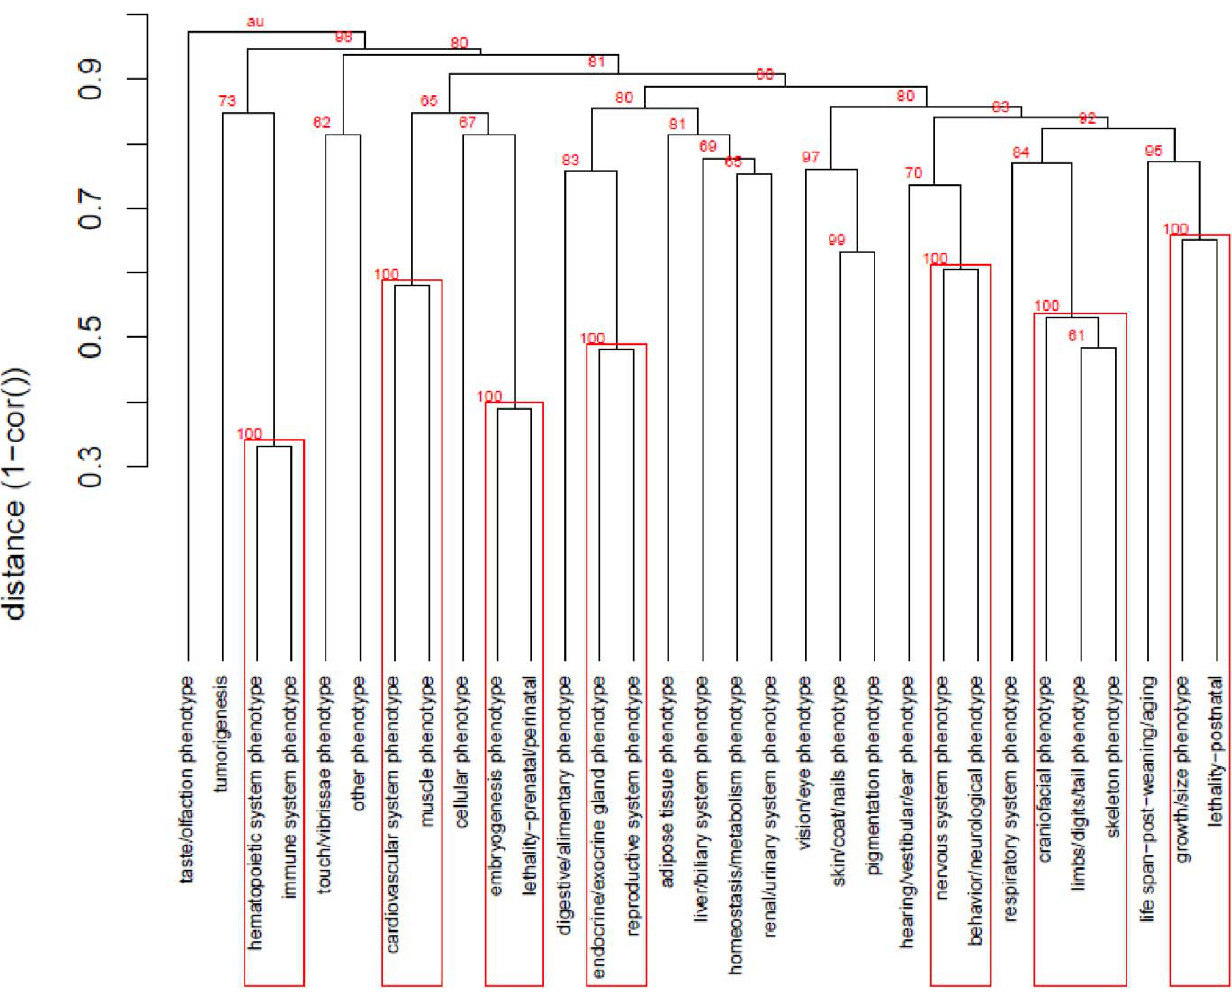
Figure 6. Hierarchical clustering of MP level 1 phenotypes according to gene commonality. Using the biadjacency matrix of genes 6 MP terms at level 1, a dendrogram was made using 1-cor() as a distance and average linkage as the agglomerative hierarchical clustering method (n n bootstrap =1 6 10 4 ). Values in red indicate the approximately unbiased (AU) values associated with the cluster.